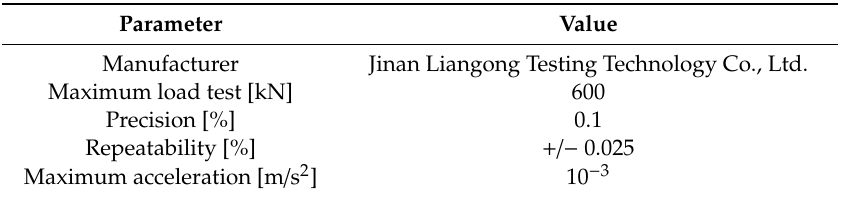
Table 3. Characteristics of universal testing machine.